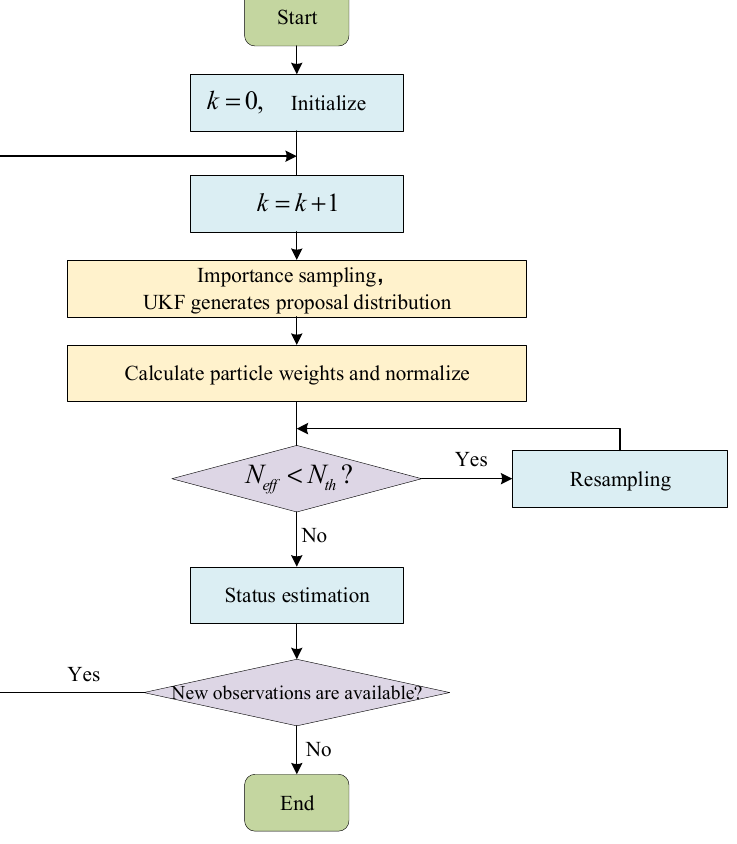
Figure 7. Flow chart of UPF algorithm.